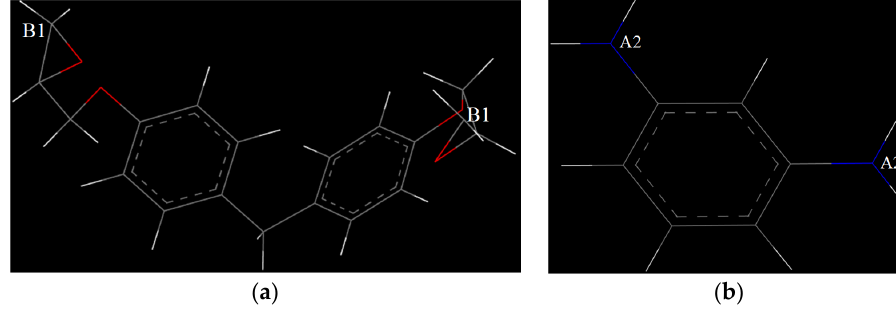
Figure 1. ( a ) Bisphenol A epoxy resin; ( b ) m-phenylenediamine curing agent.